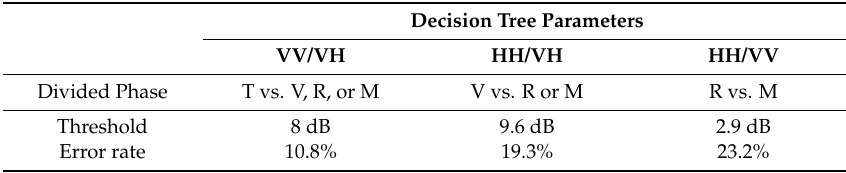
Table 3. Thresholds of selected parameters. T stands for transplanting phase, V vegetative phase, R reproductive phase, and M maturity phase. An error rate means the proportion of pixels whose backscattering coefficients cross the threshold line.